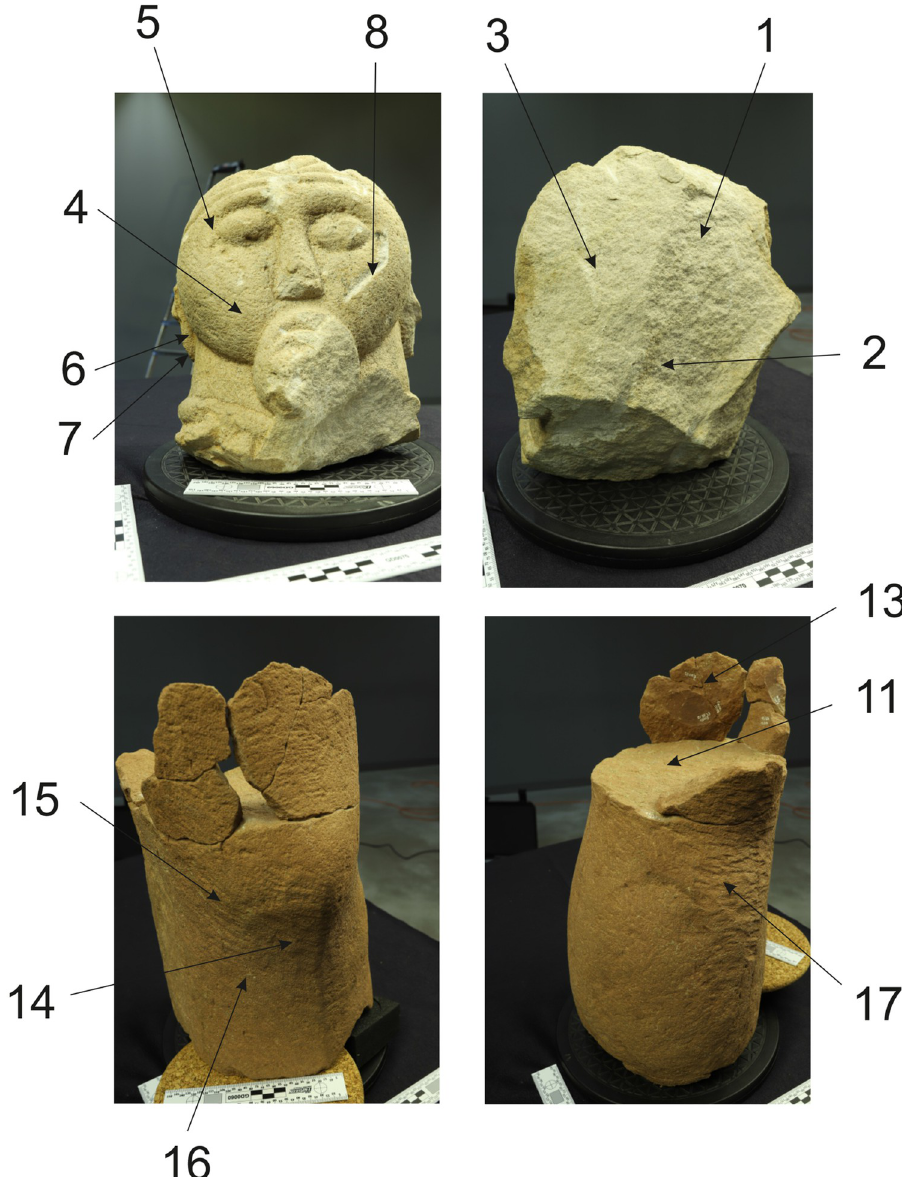
Fig 10. Points of the X-ray fluorescence measurements (author: M. Cihla and F. R.